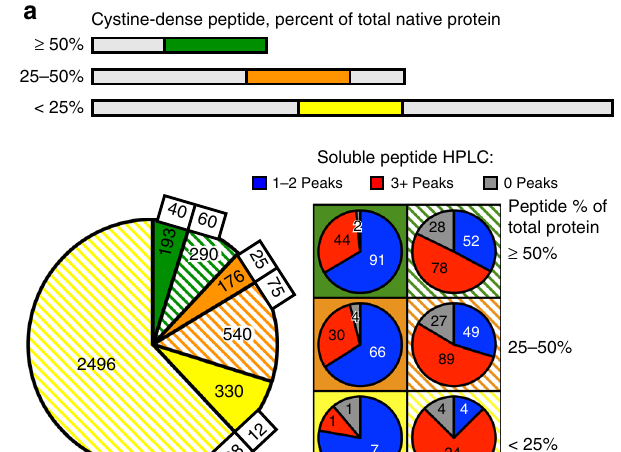
prone PCR), screens using CDP libraries with a diversity of > 10 7 variants are well within the platform ’ s capabilities.